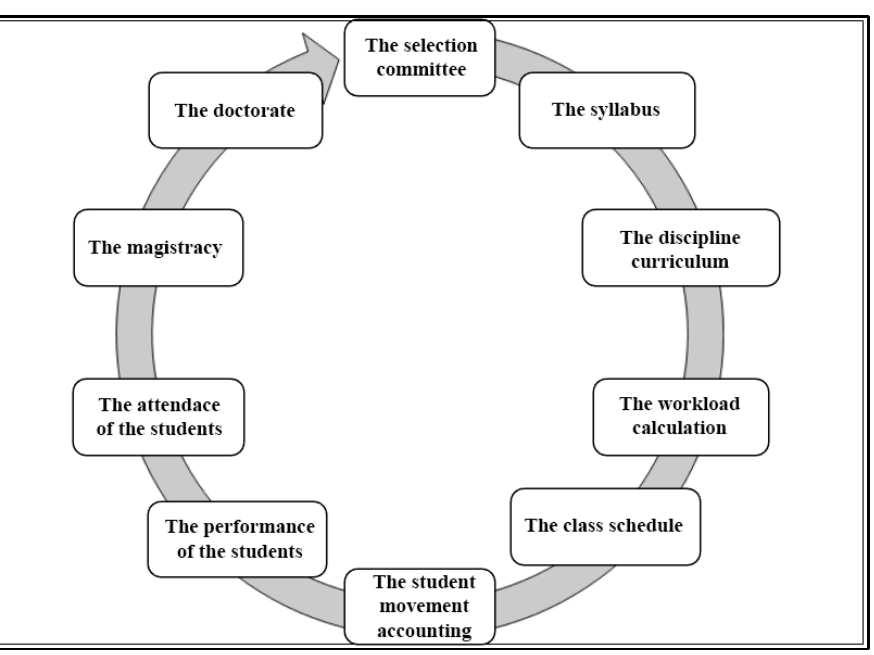
Fig. 5. The object model of KPITTU